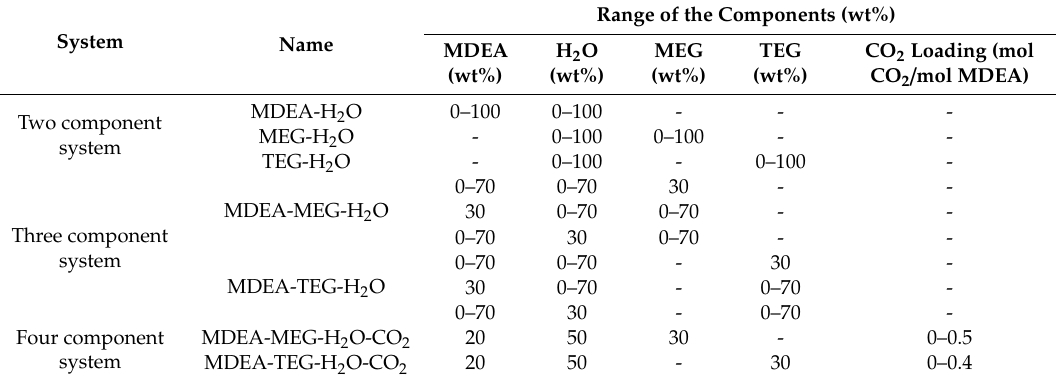
Table 2. The set of calibration solutions for each